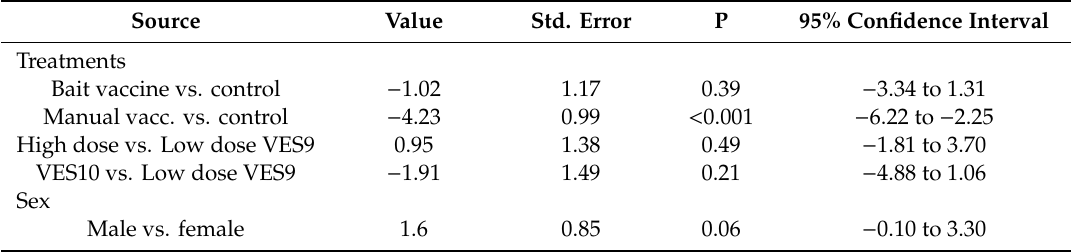
Table 6. Treatment and sex e ff ects from an analysis of variance of Disease Burden Score (DBS) across VES9 and VES10. Badgers that refused vaccine bait have been excluded from this analysis. Source Value Std. Error P 95% Confidence Interval Treatments Bait vaccine vs. control − 1.02 1.17 0.39 − 3.34 to 1.31 Manual vacc. vs. control − 4.23 0.99 < 0.001 − 6.22 to − 2.25 High dose vs. Low dose VES9 0.95 1.38 0.49 − 1.81 to 3.70 VES10 vs. Low dose VES9 − 1.91 1.49 0.21 − 4.88 to 1.06 Sex Male vs. female 1.6 0.85 0.06 − 0.10 to 3.30